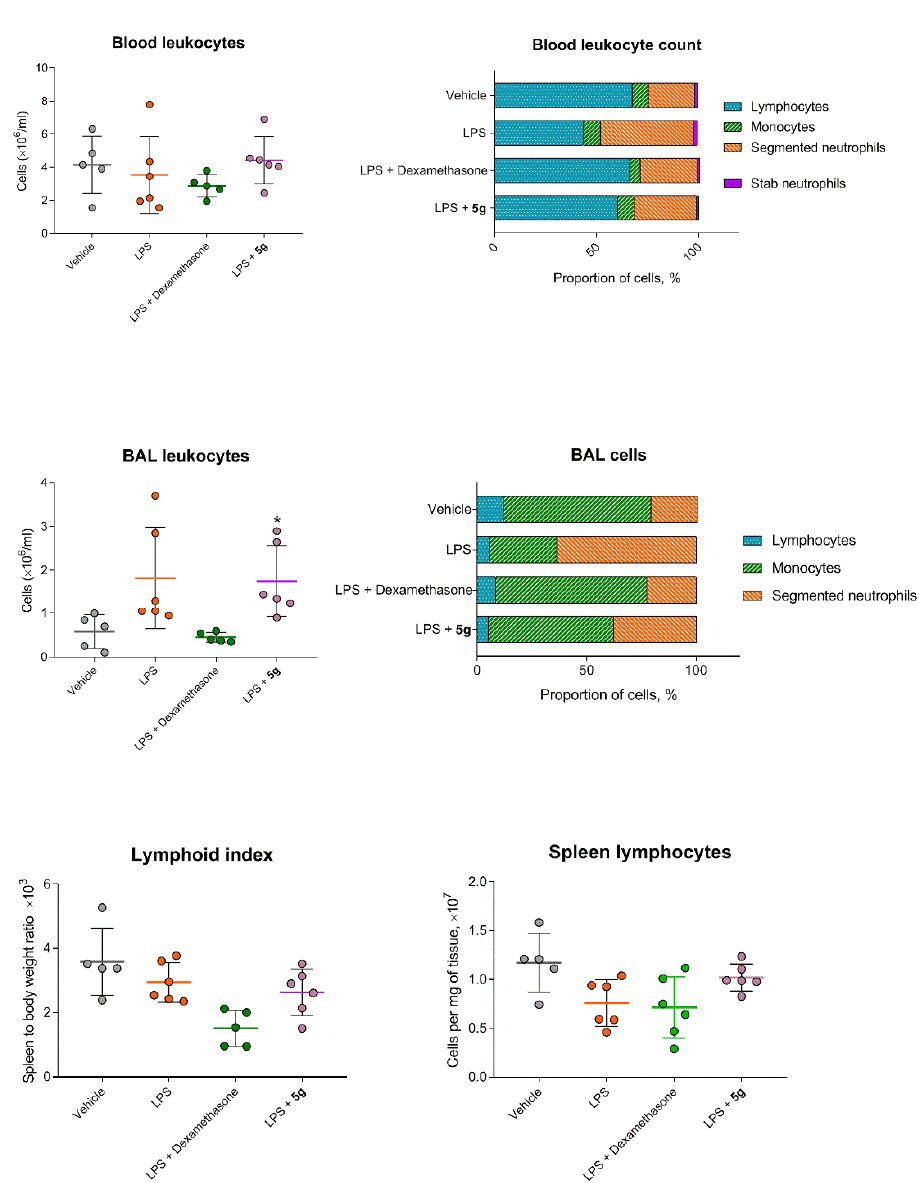
Figure 7. Effect of compounds on cytological markers of LPS-induced acute lung injury in C57bl/6j mice. Data are shown as mean ± SD; * p < 0.05 vs. vehicle (One-way ANOVA with Dunnett’s post-test).